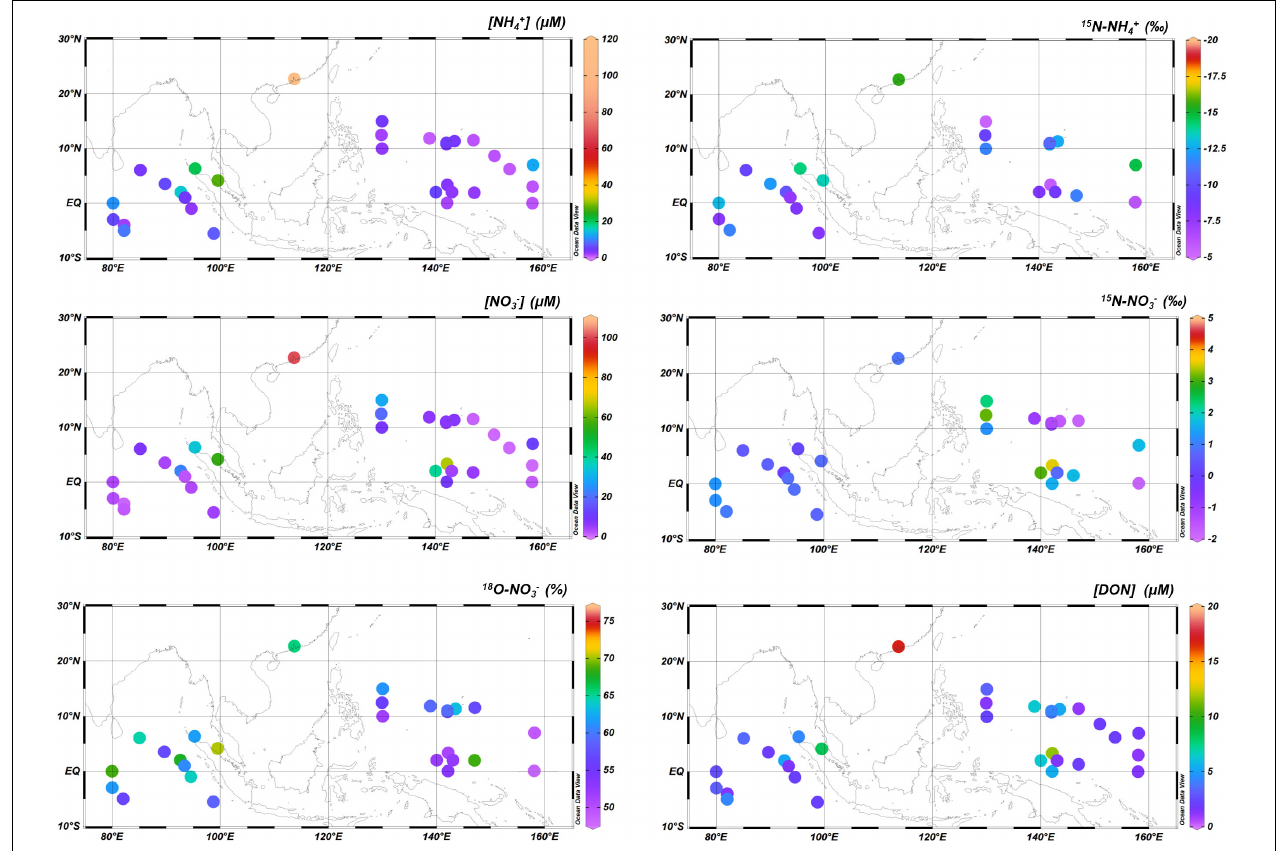
FIGURE 2 | Spatial variability of NH 4 + , NO 3 - , and DON concentrations and their isotope fractions in both EIO and WPO.